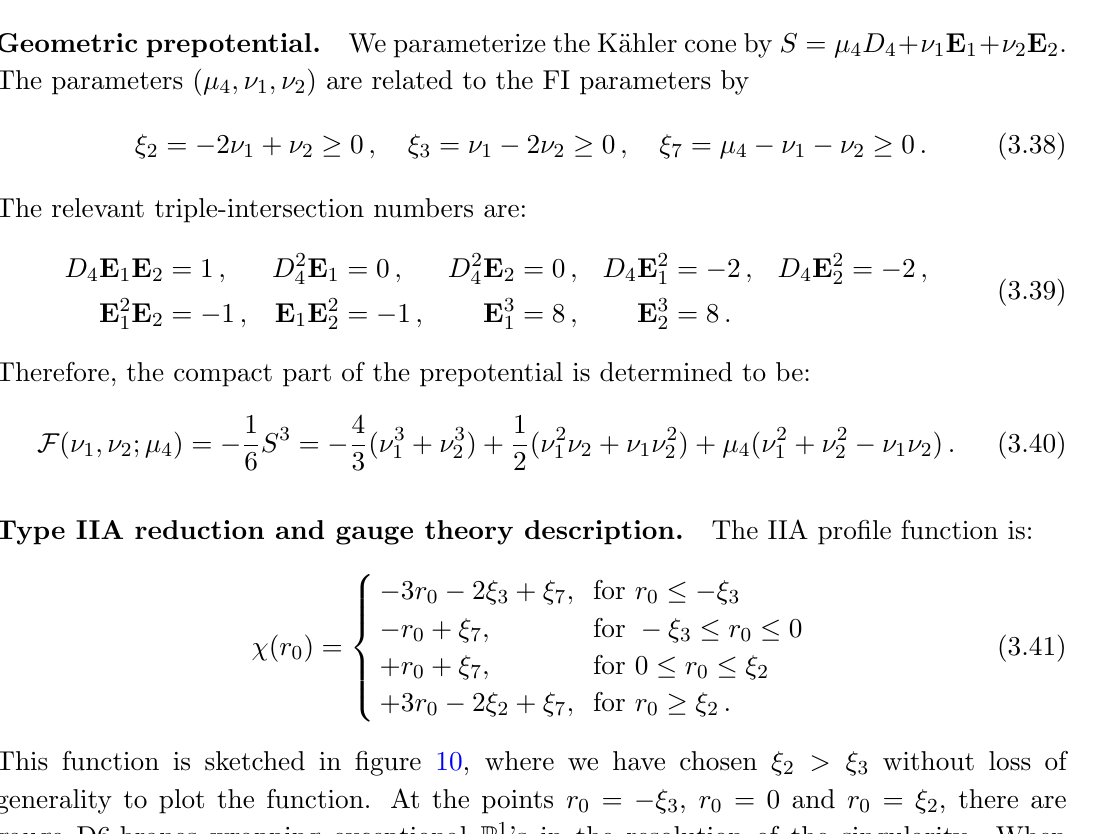
Figure 10 . Resolution (a) of the E 12 ; 0 singularity and its vertical